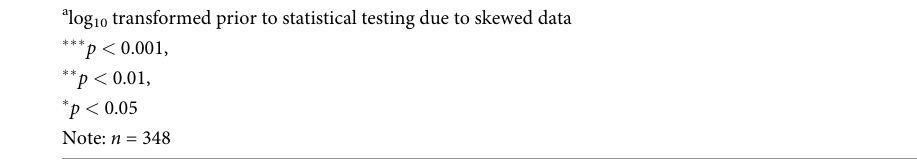
after rotation. The factor loadings suggest factor 1 represents manual and gross motor skills, factor 2 represents arm stability, factor 3 represents sensation and fine motor control, and fac- tor 4 represents tactile discrimination thresholds.